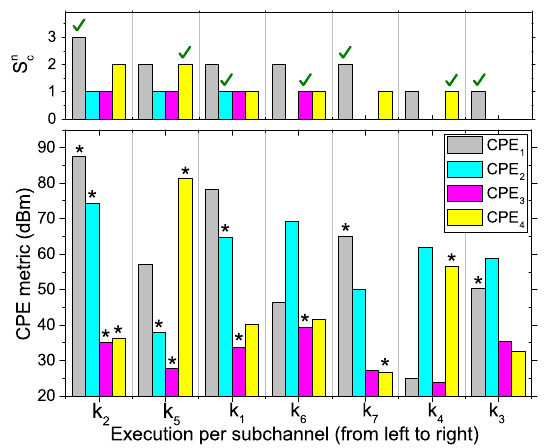
Figure 4. Step-by-step execution of Phase 3 in Algorithm